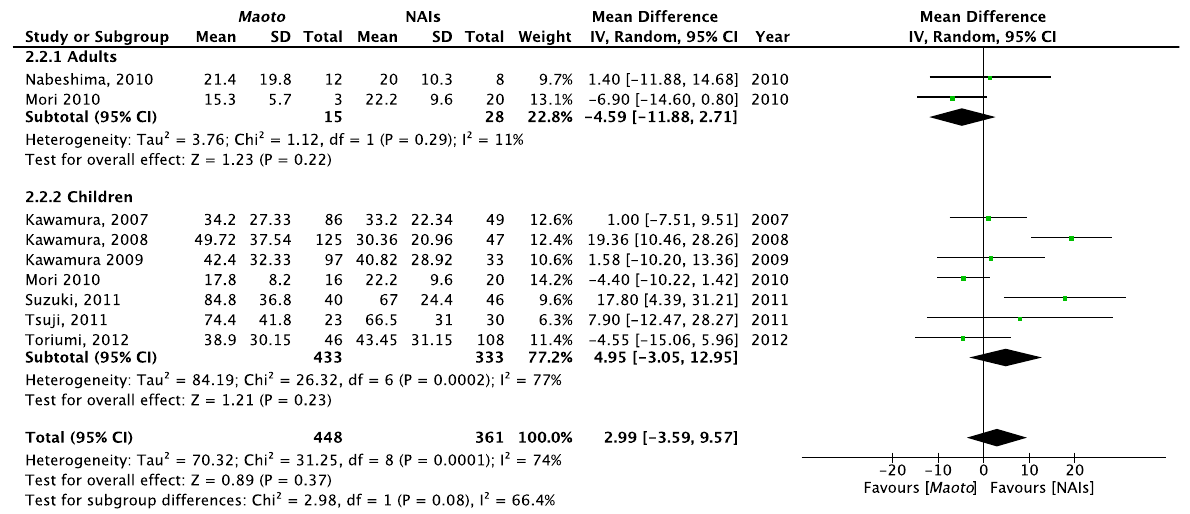
Fig. 5 Forest plot of fever duration after drug administration: maoto vs. neuraminidase inhibitors (NAIs). The duration of fever does not differ significantly between maoto and NAIs. The heterogeneity is significant ( P < 0.1, I 2 > 75%), and a random-effects model is used for this outcome. The plot shows three studies by Kawamura [19, 21, 23] and one by Nabeshima et al. [25]. The full-text articles of these studies were carefully checked for duplication of